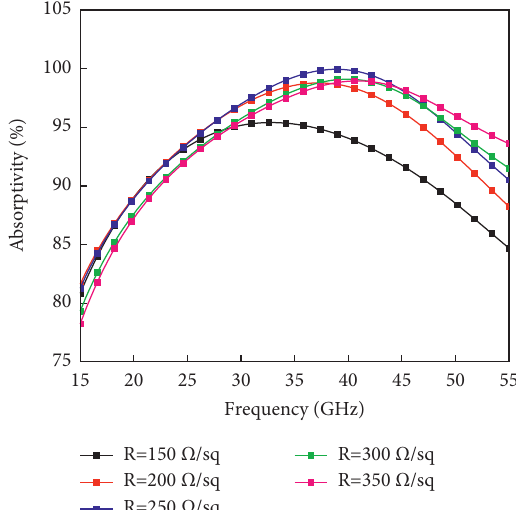
Figure 14: Reflection coefficient (left column) and input imped- ance (right column) at different substrate dielectric constant.